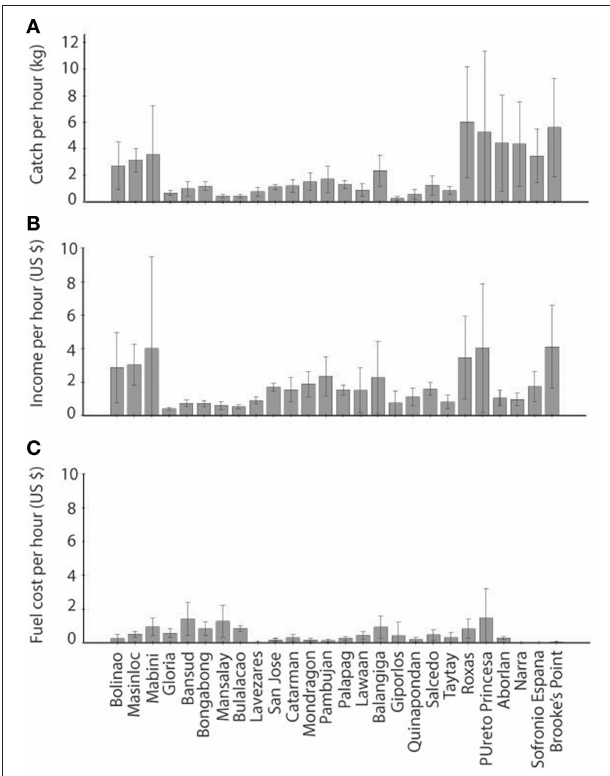
FIGURE 5 | Bar plots showing mean and SE fish catch per hour (A), mean income per hour (B), and mean fuel cost per hour (C) per fisher for each surveyed fishing municipality. Municipalities are arranged by their geographic locations, from north to south of the